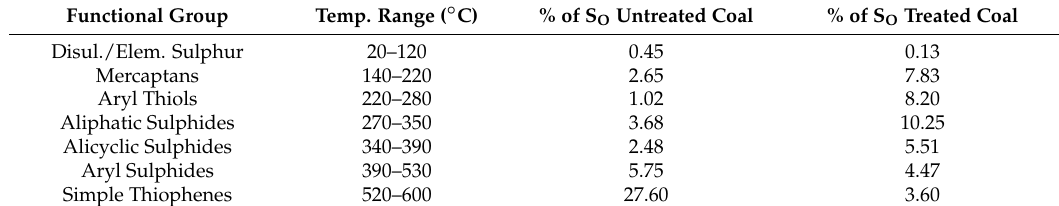
Table 6. Results for the TPR of Silverdale Coal.